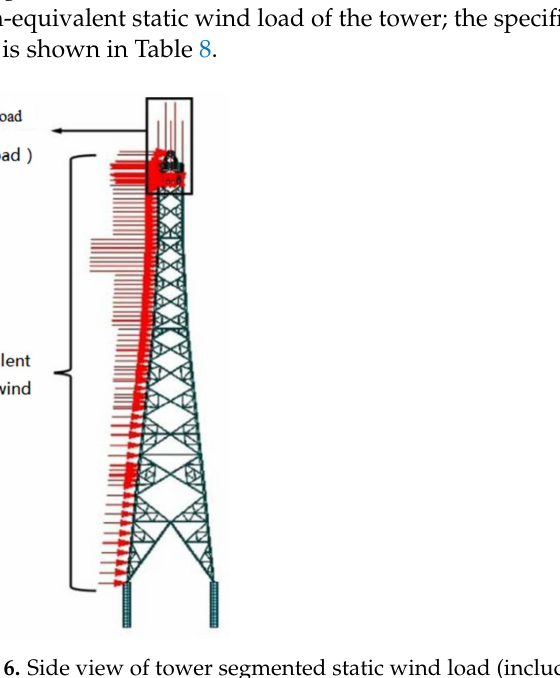
Figure 6. Side view of tower segmented static wind load (including wire